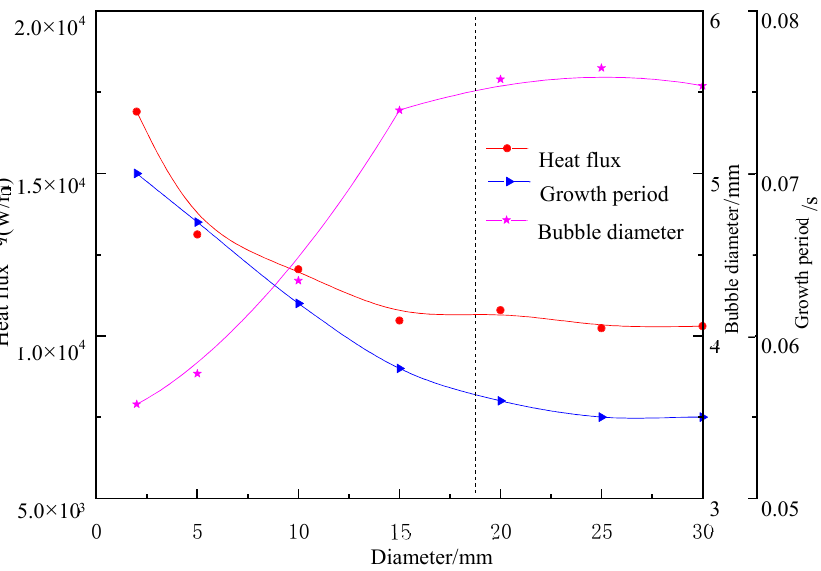
Figure 15. The thermal performance for the tube heating surface. For the wire heater, the thermal performance with various diameters is compared in Figure 16. There are two different gas–liquid interface patterns with the increase in the wire diameter. For the small-diameter wires, the heating surface is wrapped by thick gas film instead of the bubble evolution and the heat flux is small. For the large-diameter wires, the bubble diameter increases with the increase in the wire diameter and the bubble growth time decreases correspondingly. Poorer heat transfer performance is also observed as the diameter increases for the wire heating surface.